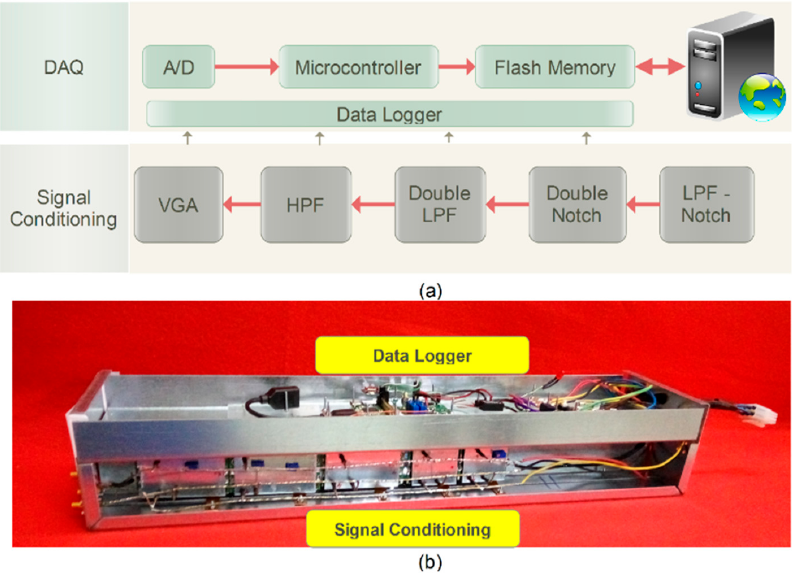
Figure 6. ( a ) Block diagram of the ELF detector (amplification, filtering, data acquisition (DAQ)); ( b ) implemented ELF detector inside metallic case.